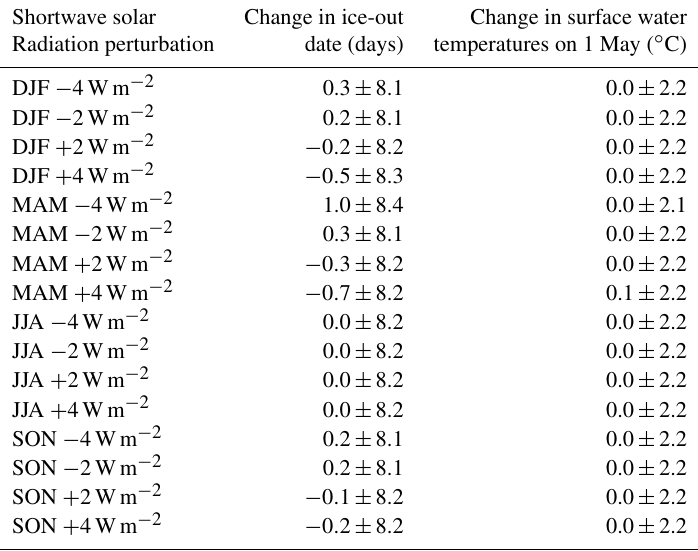
Table A5. Results from the lake energy balance model for shortwave radiation perturbations showing the change in ice-out dates and lake water temperatures relative to the control simulation (average ice-out date: 23 April ± 6d; average lake water temperature: 4.1 ± 1.5 ◦ C).